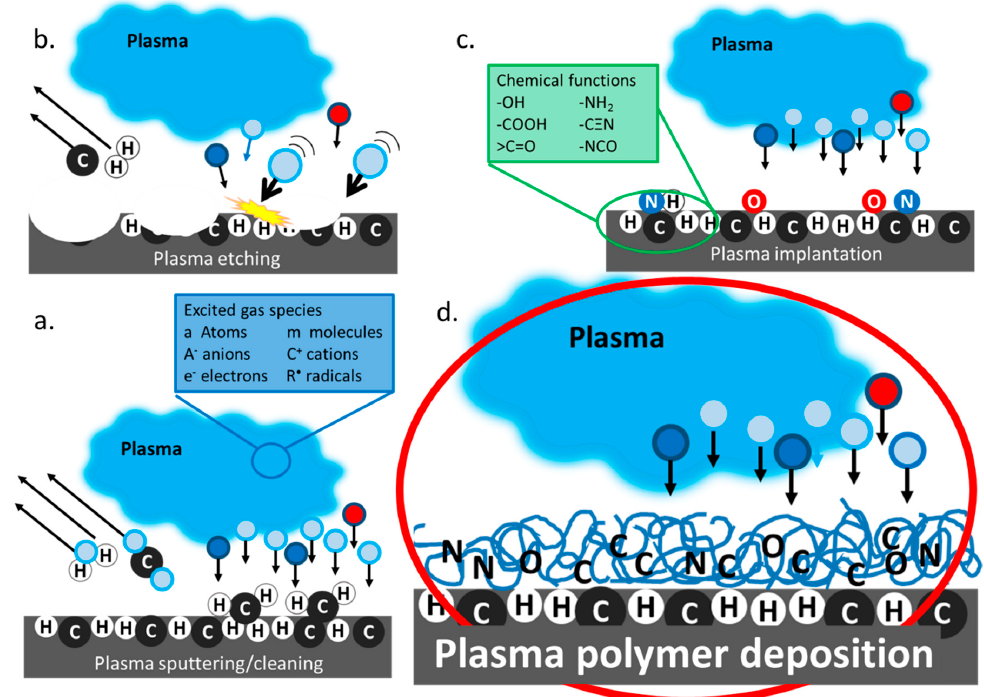
Figure 1. Plasma-assisted surface modification processes ( a ) sputtering ( b ) etching ( c ) implantation and ( d ) polymer deposition.